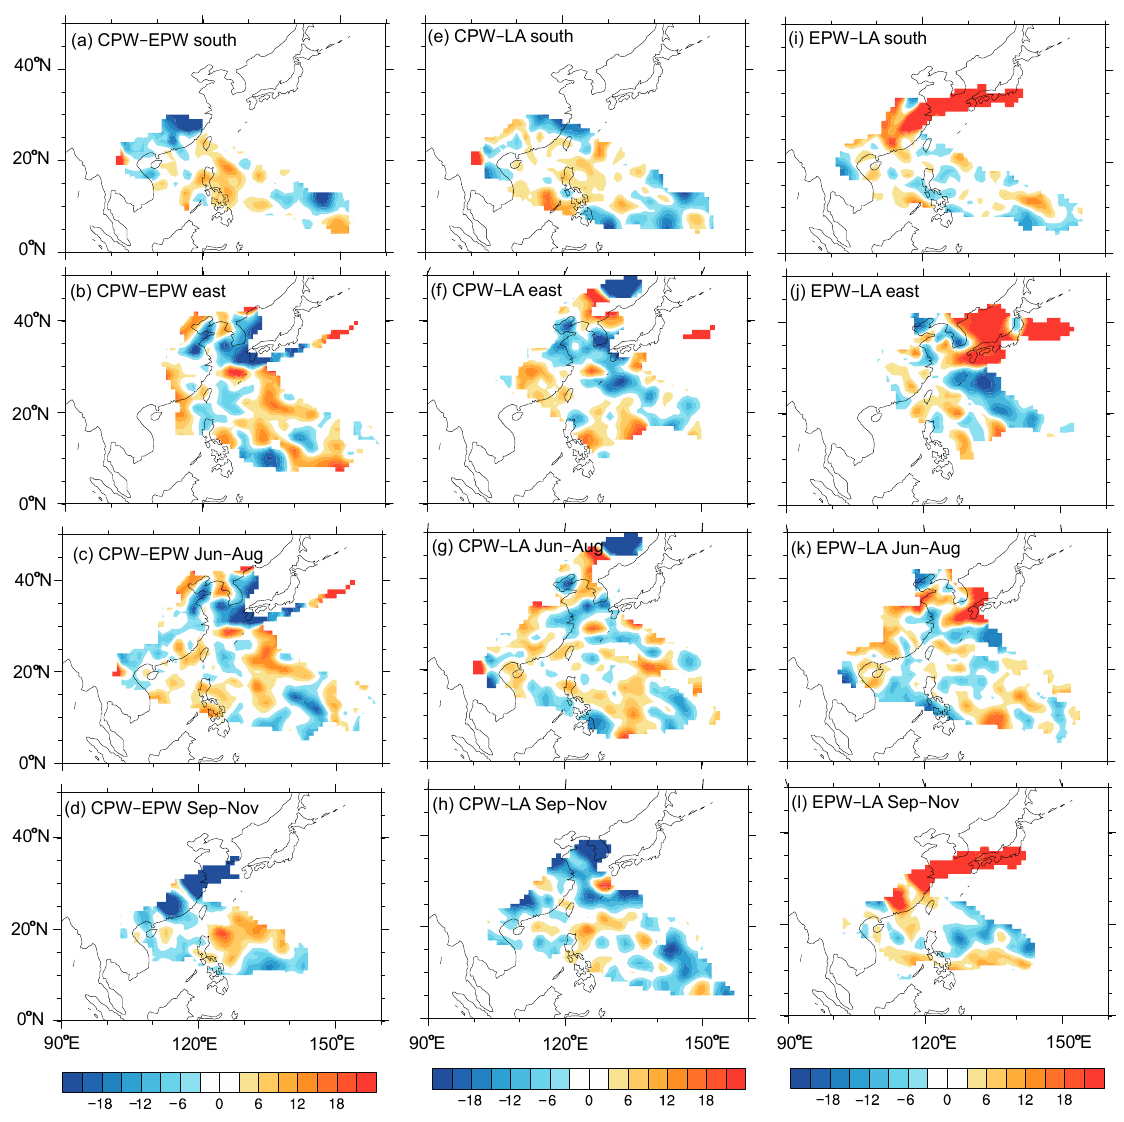
Figure 13. Composite of the differences of mean translation speed (km/h) for different seasons (JJA ( c , g , k ) and SON ( d , h , l )) and different landing locations (SC ( a , e , i ) and EC ( b , f , j )) during CPW, EPW and LA events.